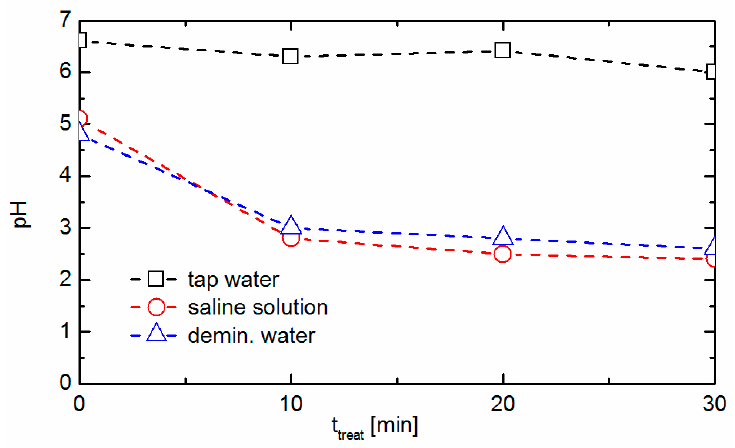
Figure 6. Change of pH-value with treatment time.